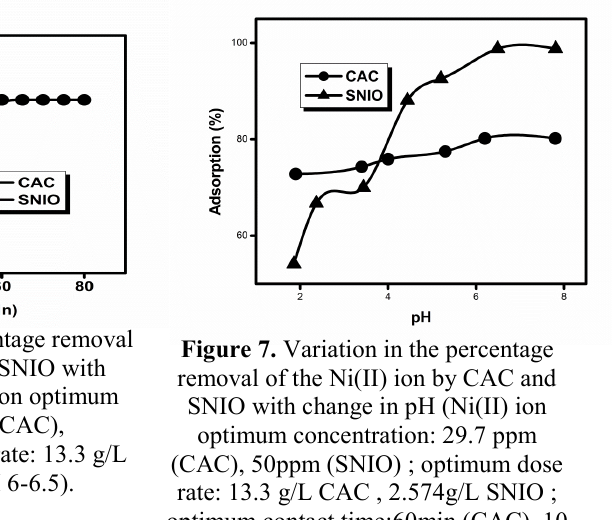
Figure 6. Variation in the percentage removal of the Ni(II) ion by CAC and SNIO with change in contact time (Ni(II) ion optimum concentration: 29.7 ppm (CAC), 50ppm(SNIO) ; optimum dose rate: 13.3 g/L CAC, 2.574g/L SNIO; pH 6-6.5).